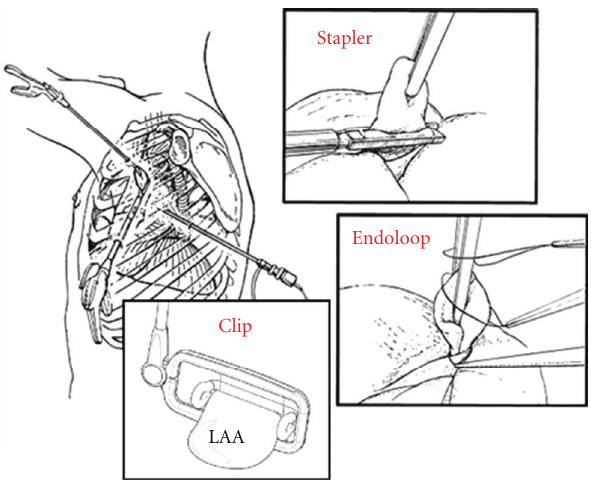
Figure 10: Surgical procedure of atrial appendage occlusion by the use of endoloop systems, staplers, or